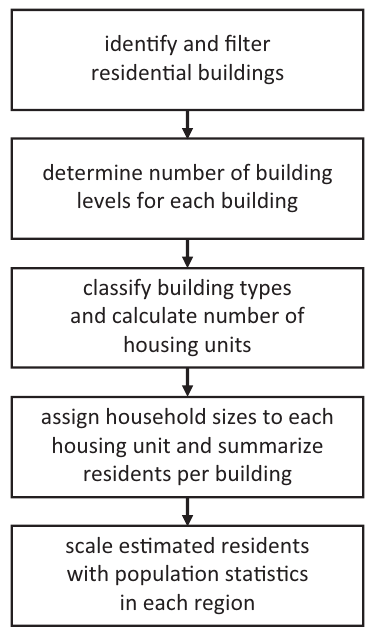
Figure 1. Workflow to estimate the number of people in residential